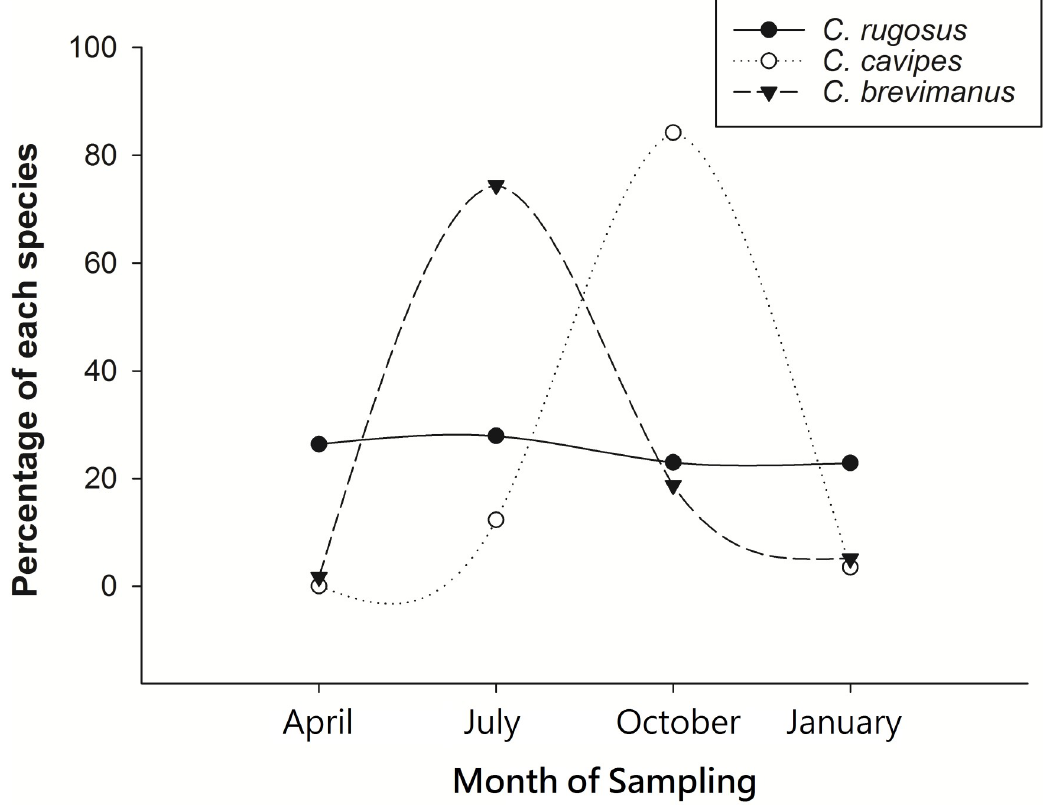
Fig 3. Relative numbers (% of total numbers captured for this study) of species of terrestrial hermit crab during April, July, October, 2017, and January, 2018. Significance of differences as tested by χ 2 -Test are given in Table 1.